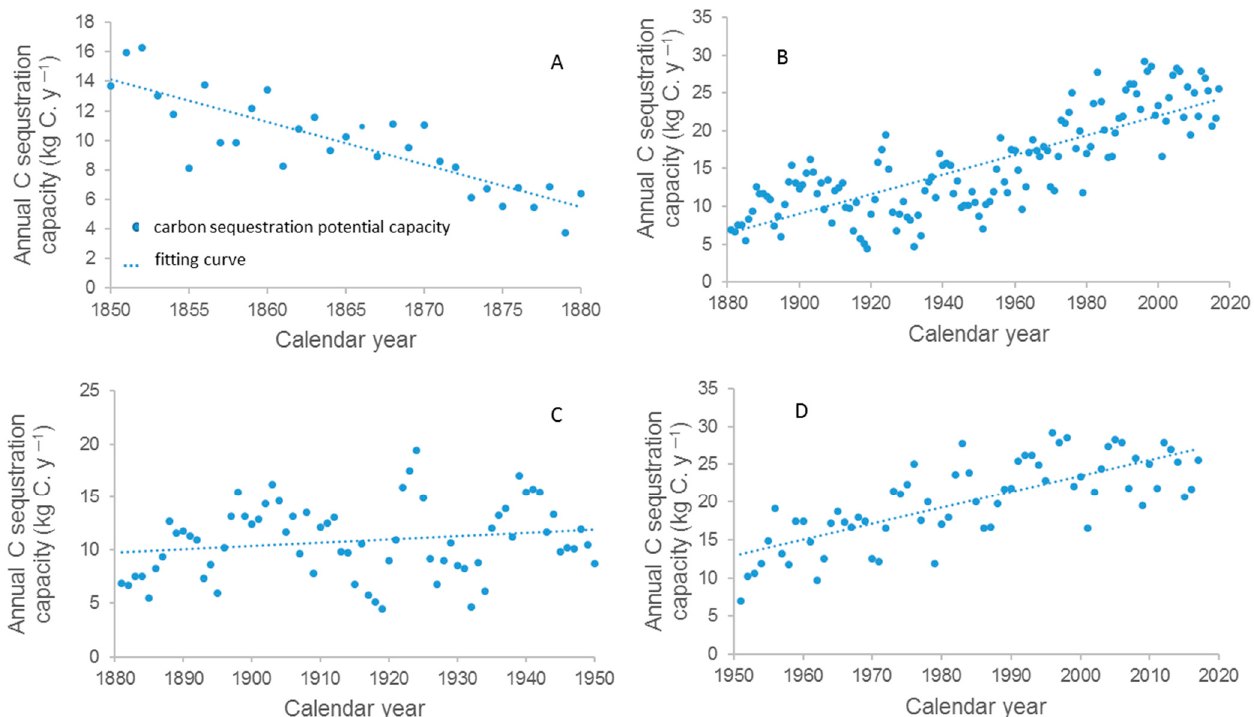
Figure 3. Change trends of carbon sequestration potential capacity in aboveground biomass of P. schrenkiana from different periods (( A ) 1850–01880; ( B ) 1881–2017; ( C ) 1881–1950; ( D ) 1951–2017) in the Tianshan Mountains. (C sequestration potential: carbon sequestration potential capacity).